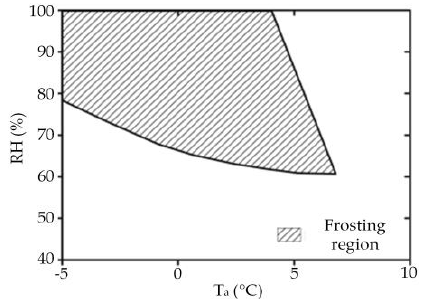
Figure 5. Frosting map developed by Adachi et al. [68].